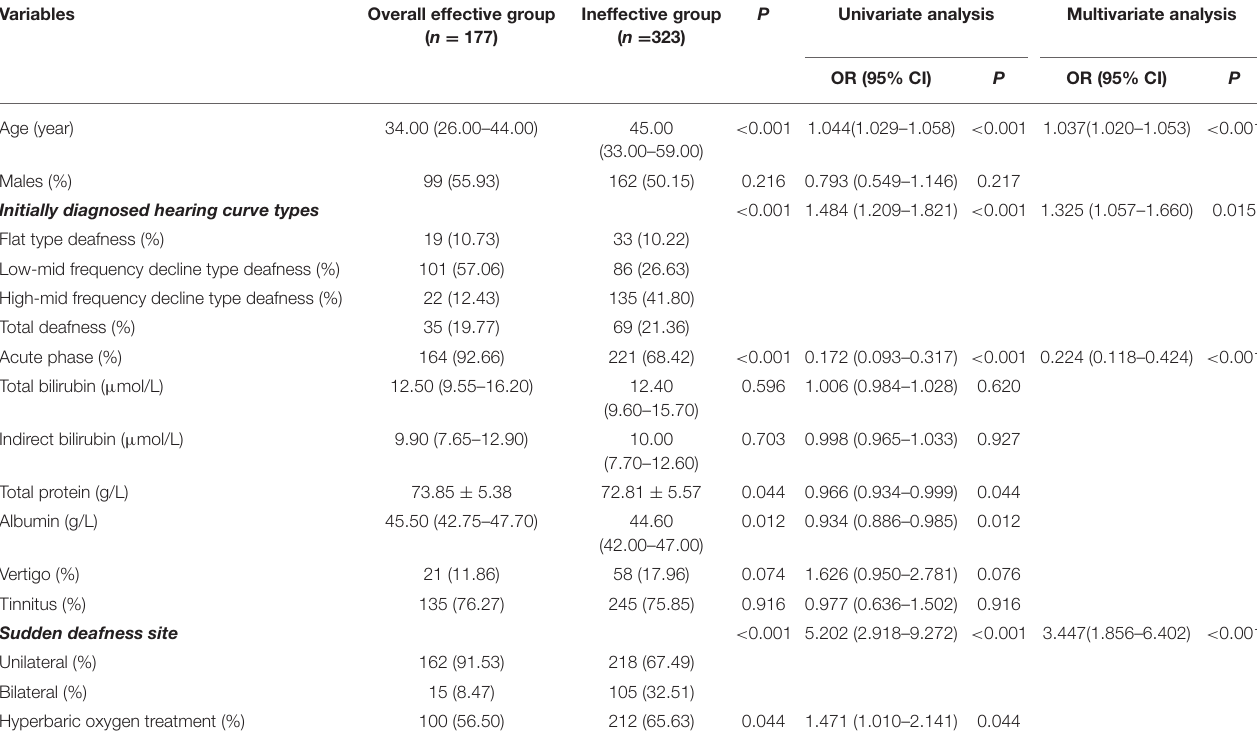
TABLE 2 | Univariate and multivariate analysis in the overall effective and ineffective groups.